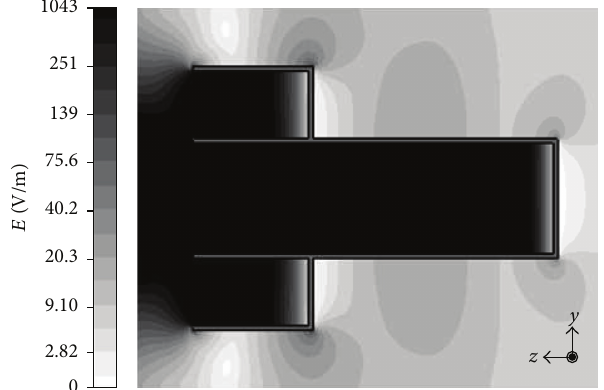
Figure 7: The simulated electric field distributions at the center of the width ( 𝑎 ) side of the antenna with parasitic coupling apertures at 2.45 GHz (side